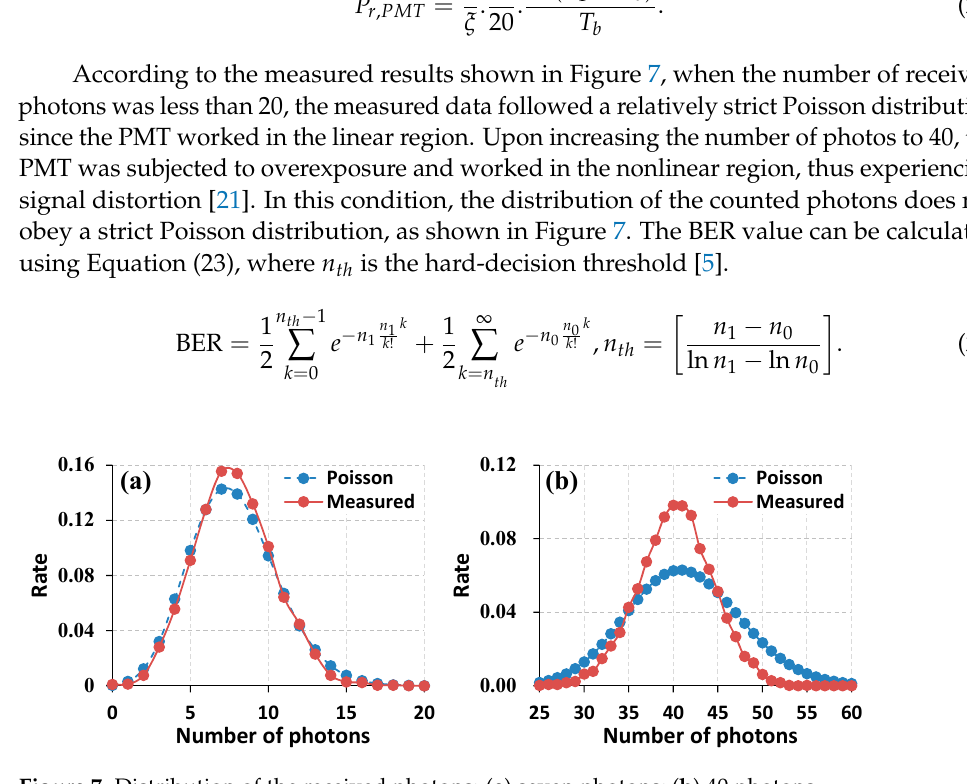
Figure 7. Distribution of the received photons: ( a ) seven photons; ( b ) 40 photons.